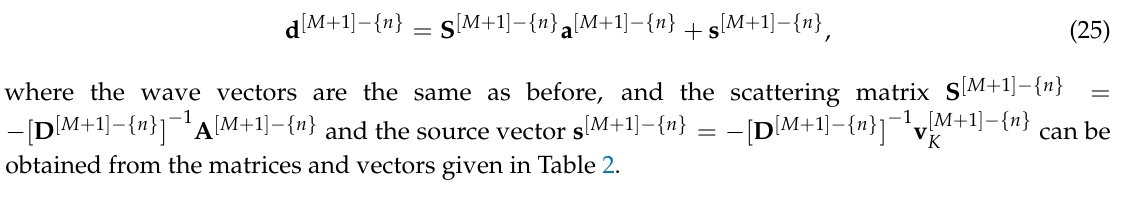
Table 1. The known and unknown quantities of four types of left exterior joint 1 − { 1 } as well as the matrices and vector for computing the scattering matrix and the source